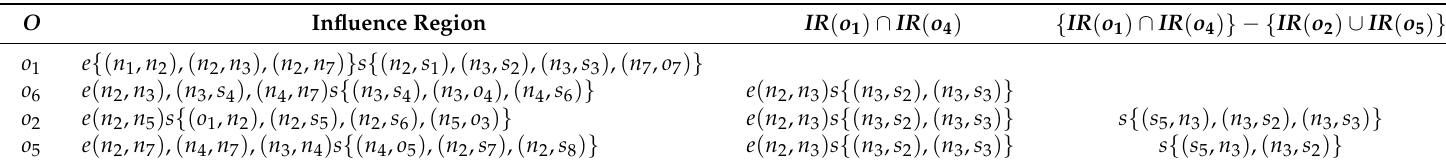
Table 3. Computation of safe region of